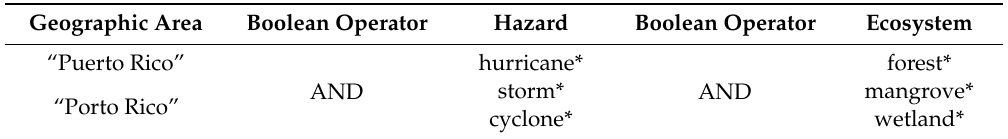
Table 1. Combination of keywords used in the systematic literature review. Boolean strings included quotation marks and